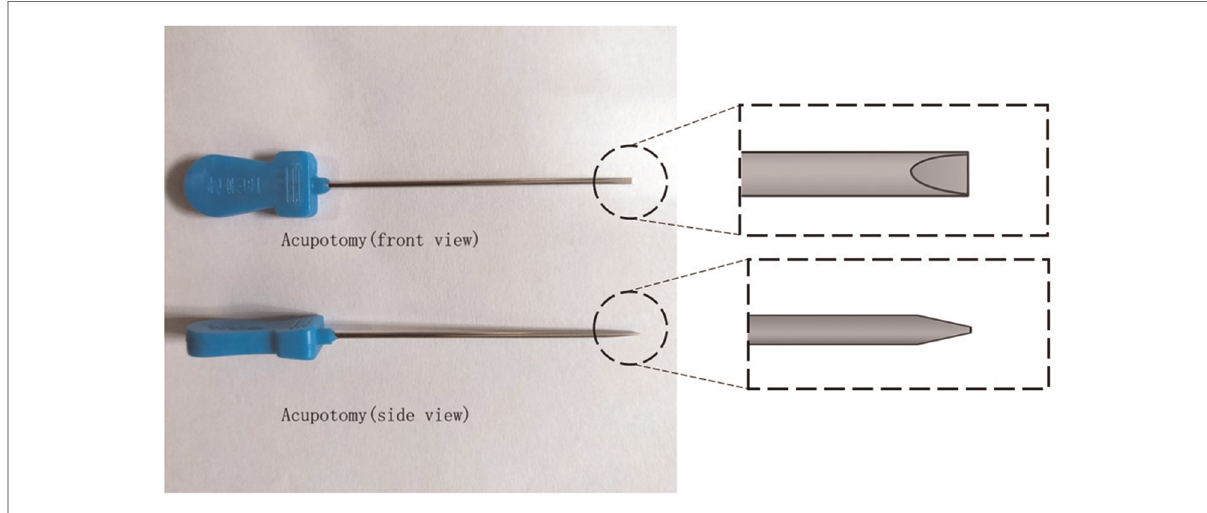
FIGURE 1 Schematic diagram of the